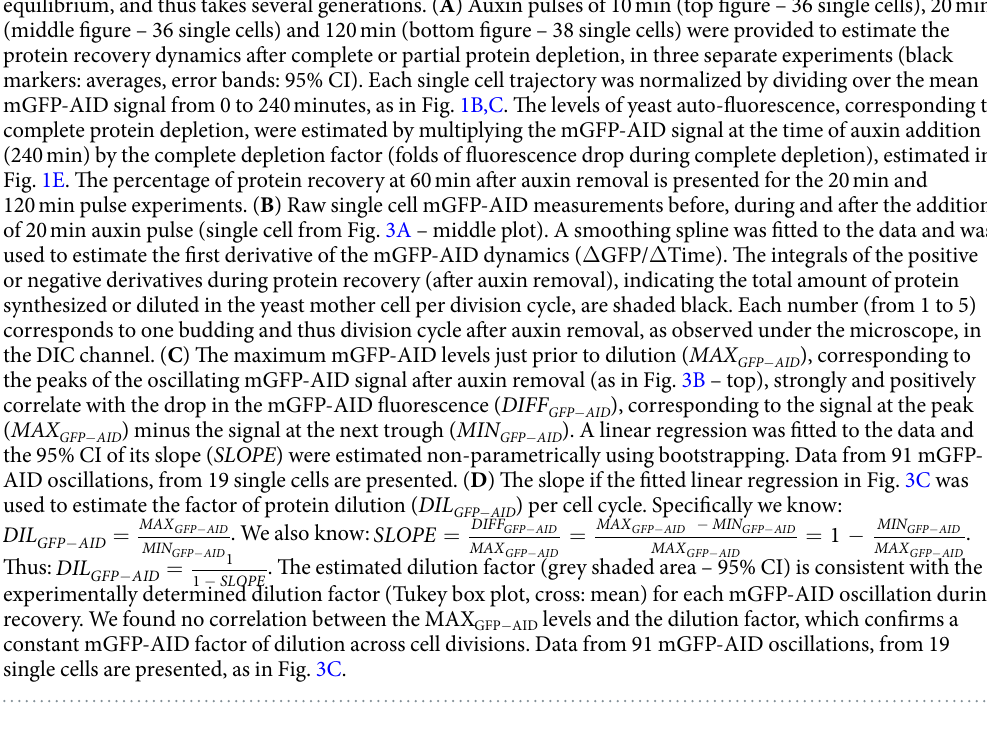
fluorescent proteins, which can be used to monitor other than the targeted proteins during conditional depletion, and thus increases the versatility of the AID system on the single cell level. Next, also using the control strain (mGFP-AID), we tested if we could discriminate between off-target growth defects and those specific to the conditional depletion of the N-acetyltransferase. Before the addition of auxin, we found the Gcn5-mCherry-AID cells to exhibit significantly (Kruskal-Wallis test, Dunns post-test, p < 0.01 ** ) slower growth, when compared to the control mGFP-AID cells (Fig. 4C – 0 mM), indicating either a basal level of Gcn5 depletion or an effect of the degron tag on the activity of the protein. Immediately after the auxin addition,